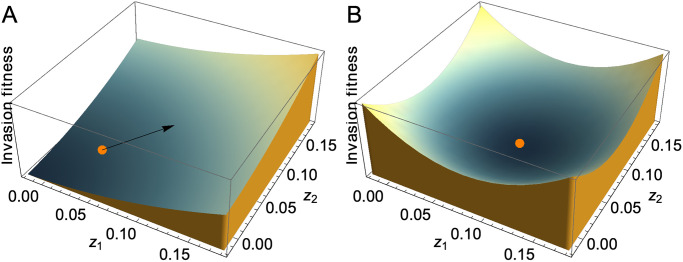
Fitness landscape during approach to the branching point (A) and at the branching point (B).A: When the resident (orange dot) is away from the branching point (tip of arrowhead), it moves up the fitness landscape. B: When the resident (orange dot) is at the branching point, the fitness landscape in our model is symmetric about the resident: all mutants equidistant to the resident have equal invasion fitness. Hence, invasion fitness alone does not predict any particular direction of branching.